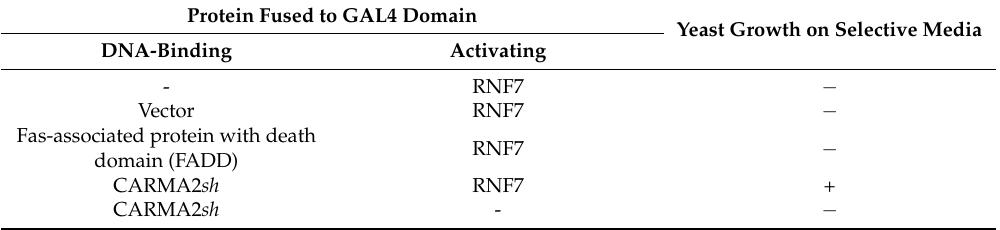
Table 1. Interaction of CARMA2 short (CARMA2 sh ) with RING finger protein 7 (RNF7) in the yeast two-hybrid